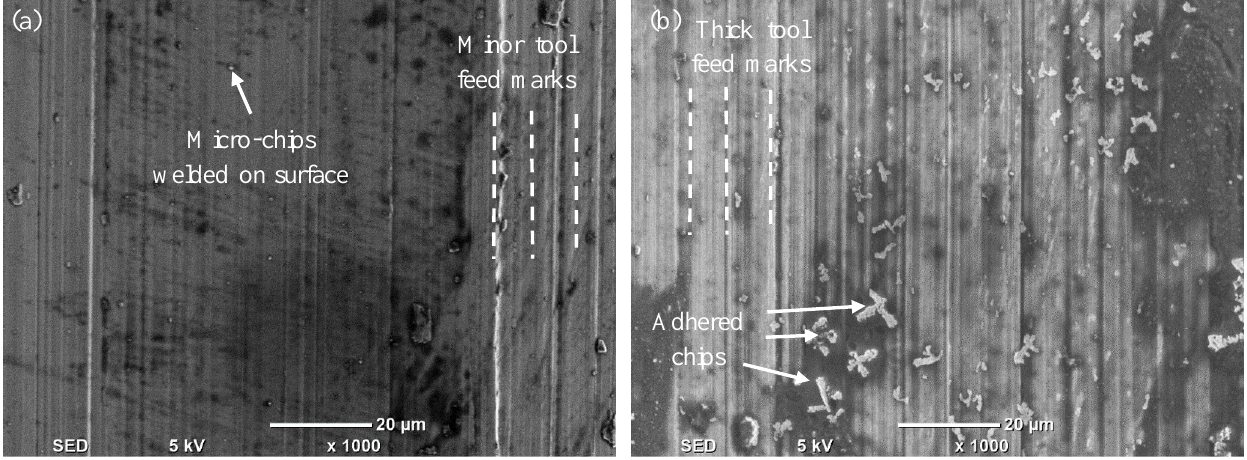
Figure 15. Turned surface images for the two orientations using SEM: ( a ) AL orientation and ( b ) PL orientation at V = 60 m/min, f = 0.1 mm/rev, and d = 0.2 mm.